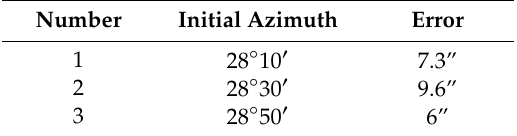
Table 1. Errors in determining the azimuth of the Angular Velocity Sensors (AVS) sensitivity